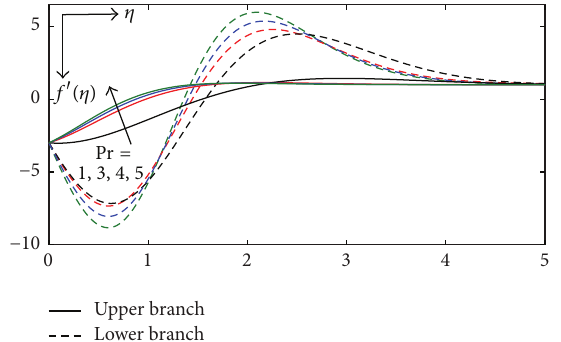
Figure 13: Velocity profiles for various values of Pr with 𝑠 = −3 , 𝛾 = 1 , 𝜆 = 0.5 , and 𝑀 = 0.2 .